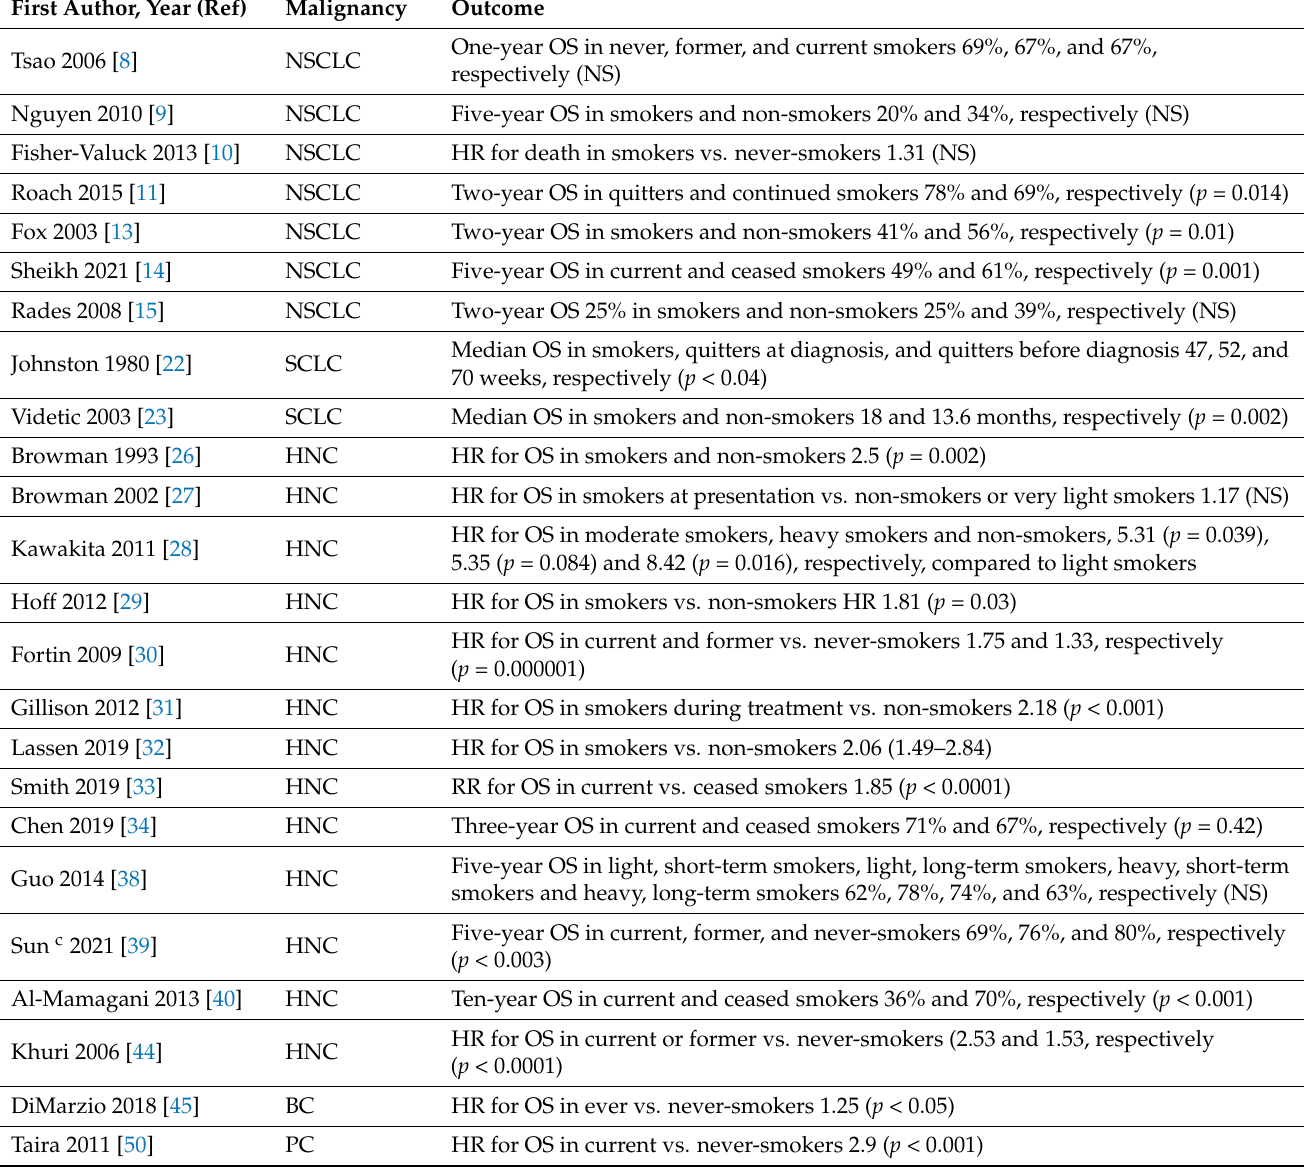
Table 2. Impact of tobacco smoking on overall